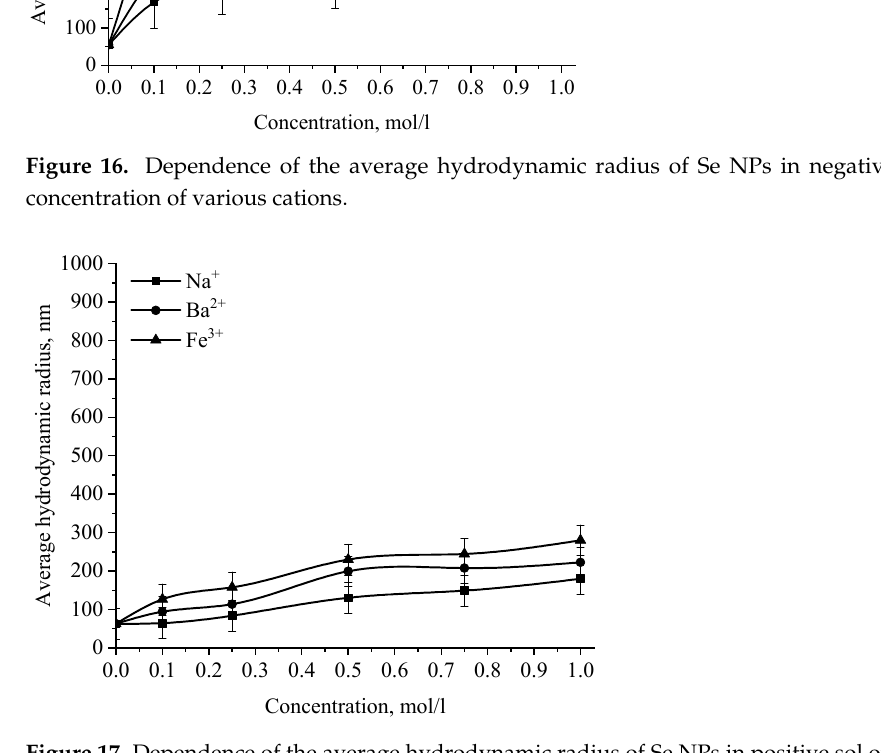
Figure 17. Dependence of the average hydrodynamic radius of Se NPs in positive sol on the concen- tration of various ions.